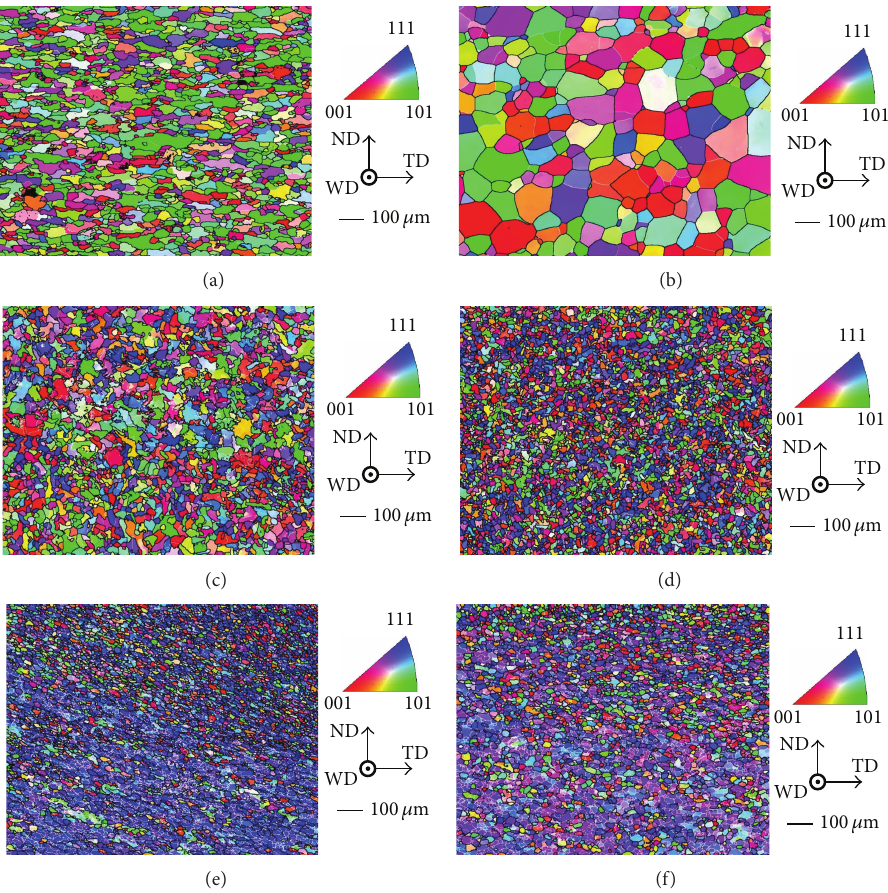
Figure 5: Orientation maps of the base material in (a) SPCC and (b) SUS and the stir zone in (c) SPCC/SPCC, (d) SPCC/SUS, (e) SUS/SPCC, and (f) SUS/SUS, respectively; WD, TD, and ND, respectively, correspond to the welding, transversal, and normal